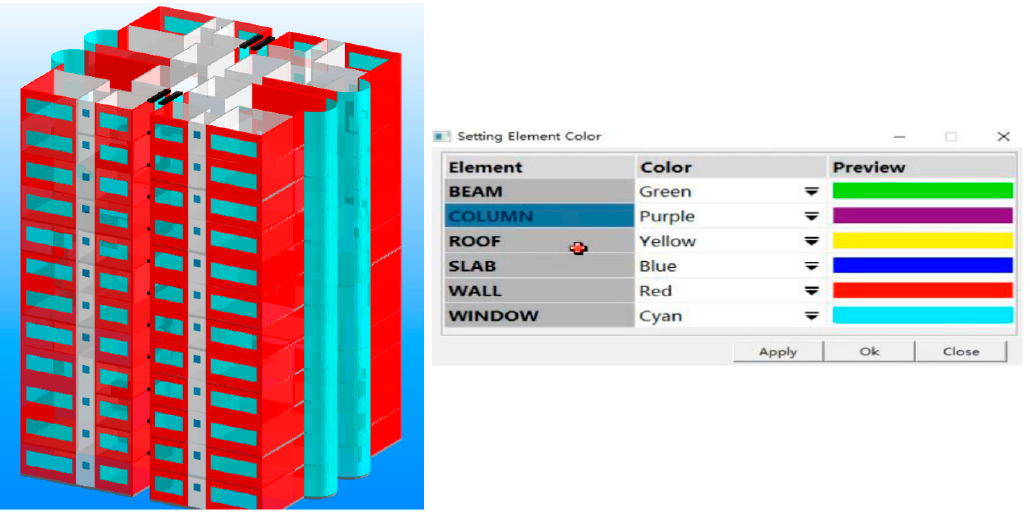
Figure 4. Model elements are mapped with the equation.